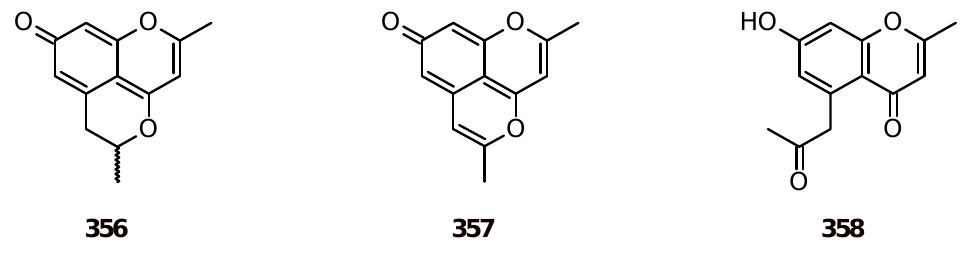
Figure 43. Structures of chromenes